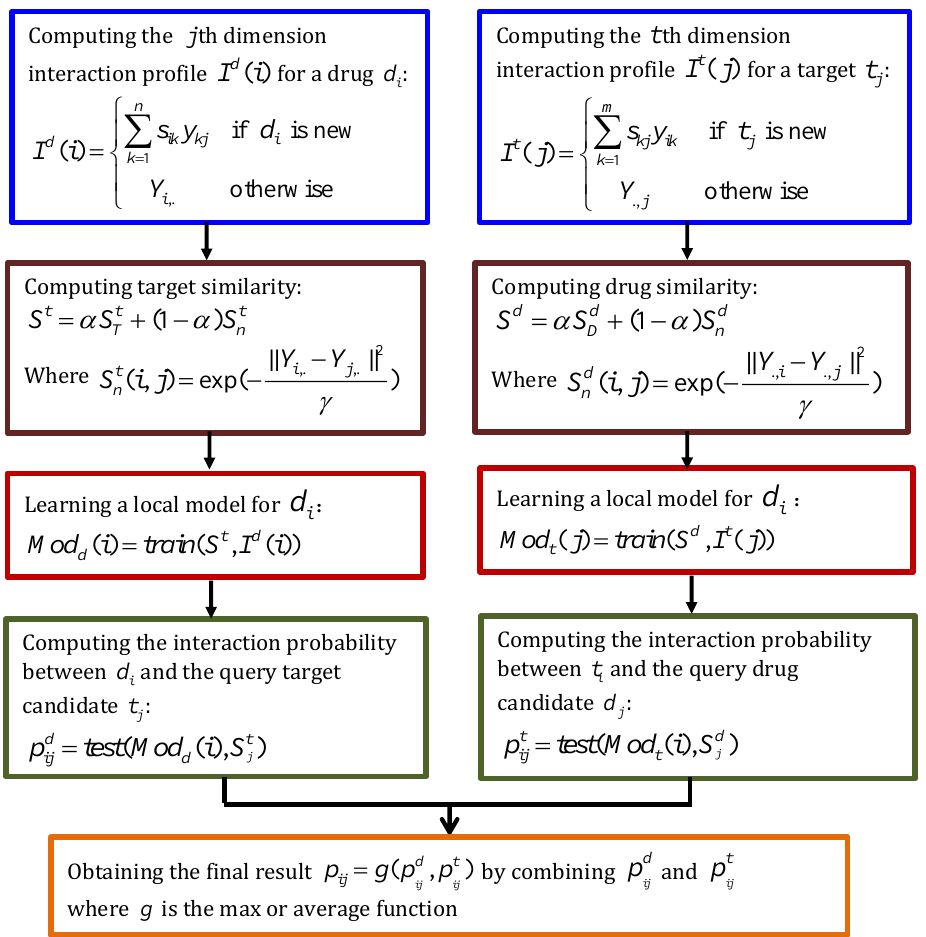
Figure 6. The flowchart of BLM with neighbor-based interaction-profile inferring